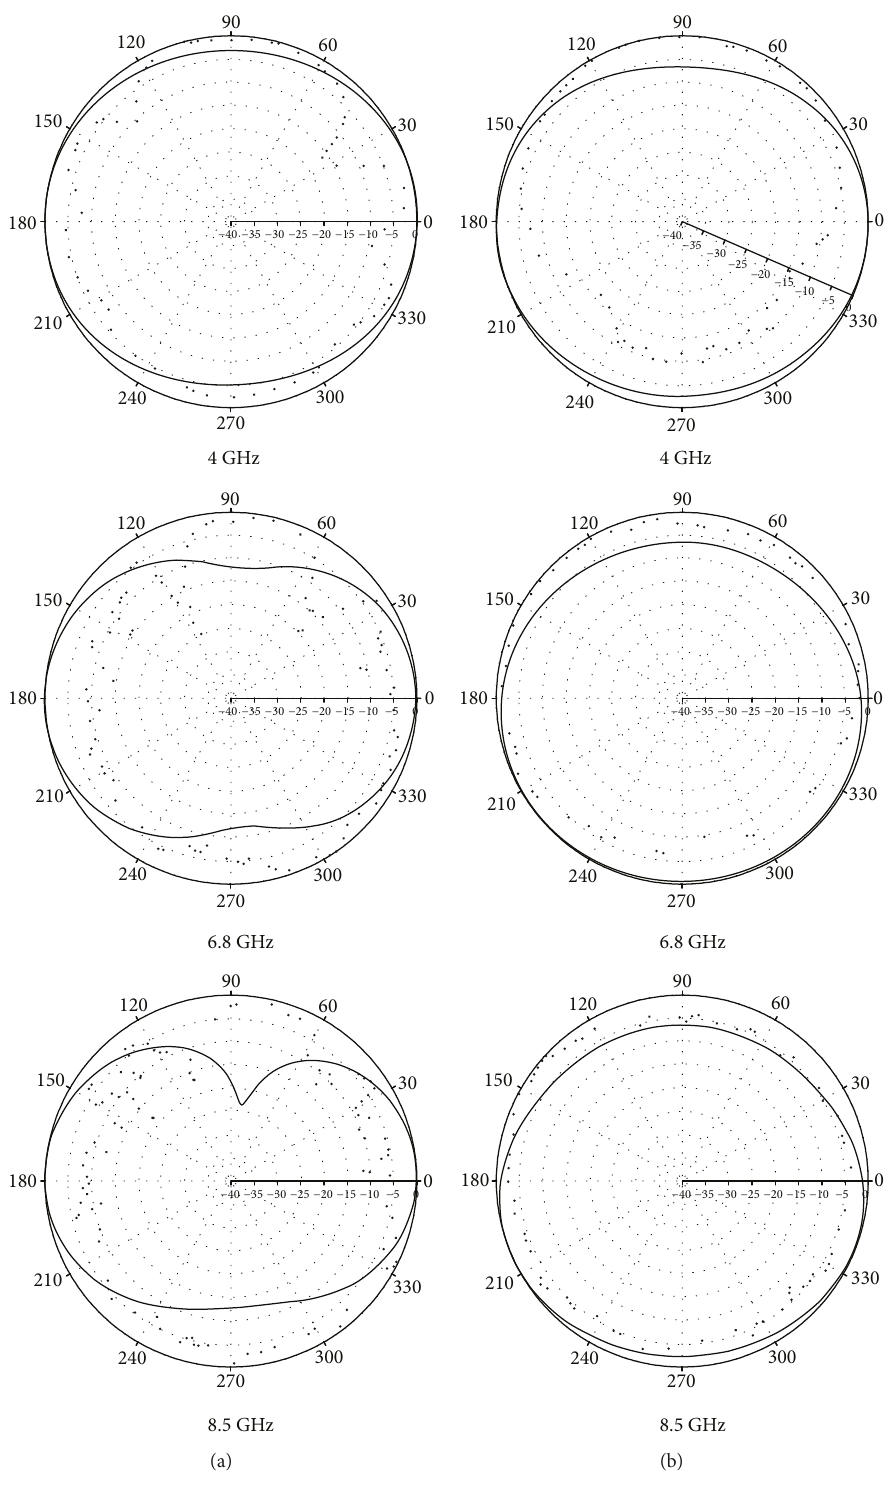
Figure 11: The measured and simulated radiation patterns of the proposed MIMO antenna. (a) H -plane. (b) E